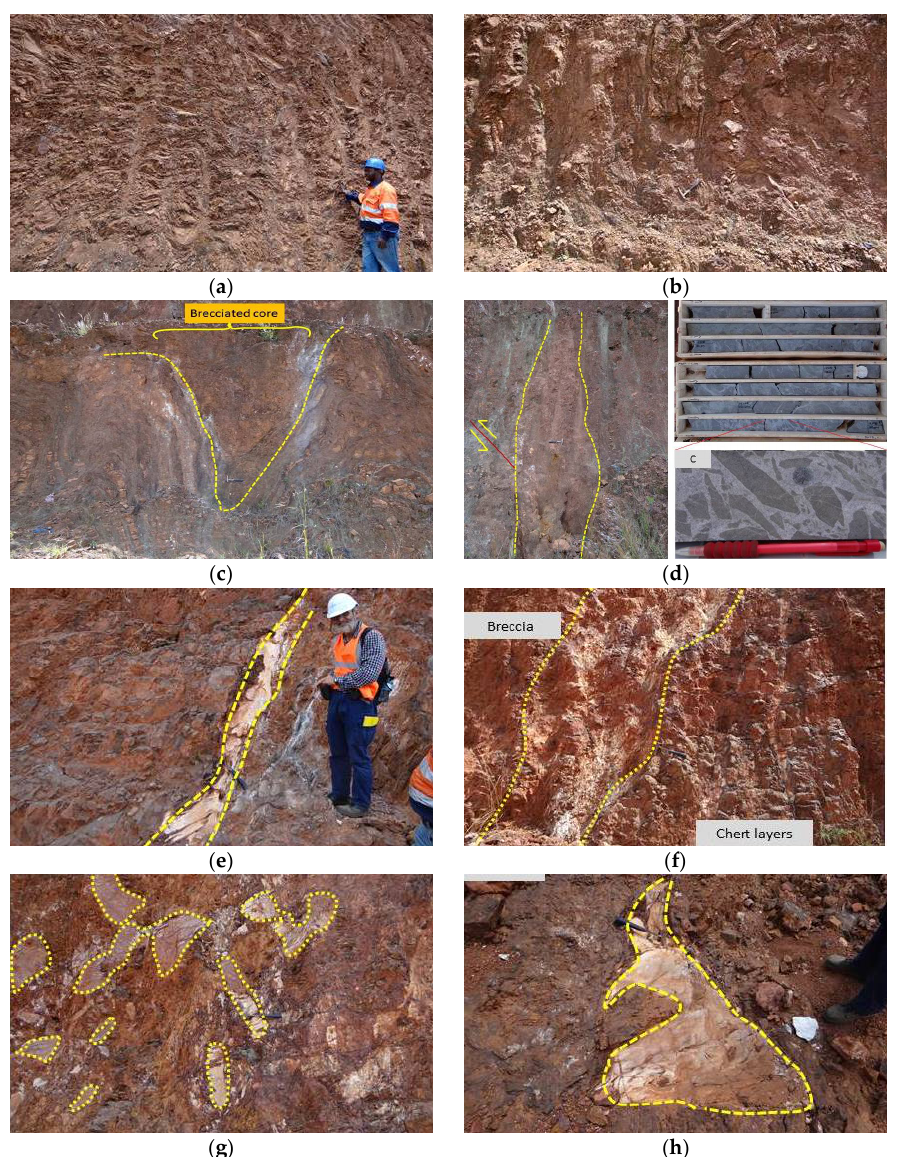
Figure 11. Examples of hydrothermal, syn-D 3 breccia and intrusions in Kukuluma pit: ( a , b ) Progressive brecciation in meta-ironstones, including a complexly folded zone with crackle breccia, in which the original folded bedding is still visible ( a ), and more advanced brecciation, in which individual clasts have moved, but remnants of underlying folds are visible ( b ); ( c ) Layer-parallel breccia in the core of a D 3 fold; ( d ) Fine-grained breccia pipe transecting a folded meta-ironstone package. The inset shows hydrothermal breccia in a diorite intrusive (drill hole ID: MTRD0005-588m); ( e , f ) Diorite dyke (outlined with yellow stipple line) with highly irregular margins is emplaced into the breccia zone; ( g , h ) Irregular blebs and fragments of diorite (outlined with yellow stipple line) mixed within the breccia near the intrusive contacts of the dyke shown in ( e , f